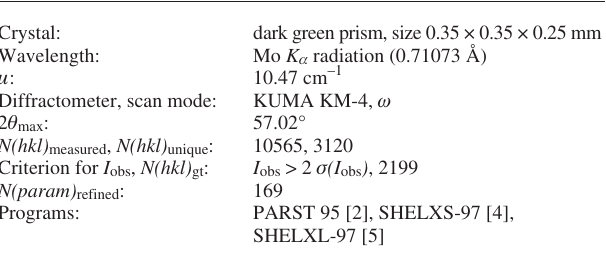
Table 1. Data collection and handling.